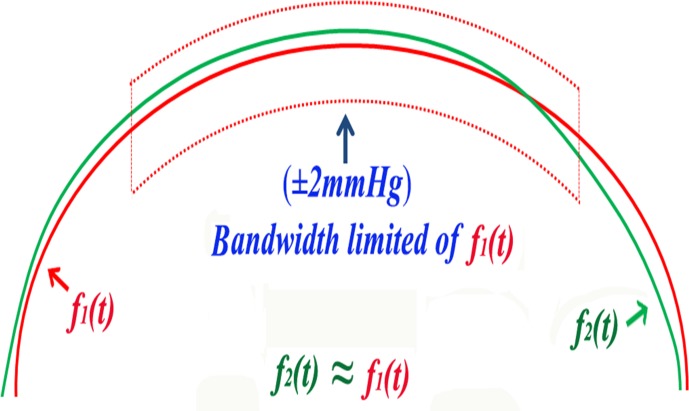
A function travels within bandwidth of another function.